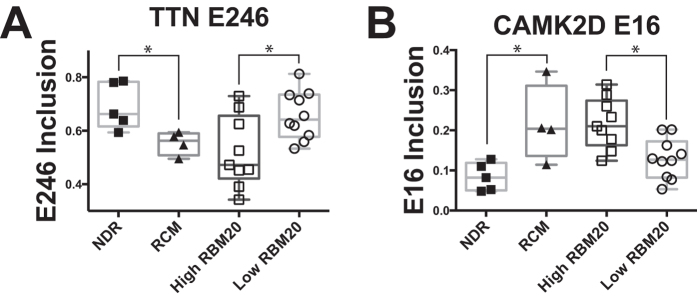
RBM20 regulated splicing events.Alternative splicing events for (A) titin (TTN) exon 246 inclusion, and (B) calcium/calmodulin-dependent protein kinase (CAMKD2) exon 16 inclusion in our RCM dataset and prior set of DCM patient samples with high and low RBM20 expression (E-MTAB-2572)78. Relative levels of exon inclusion are shown for the respective datasets. *p < .05